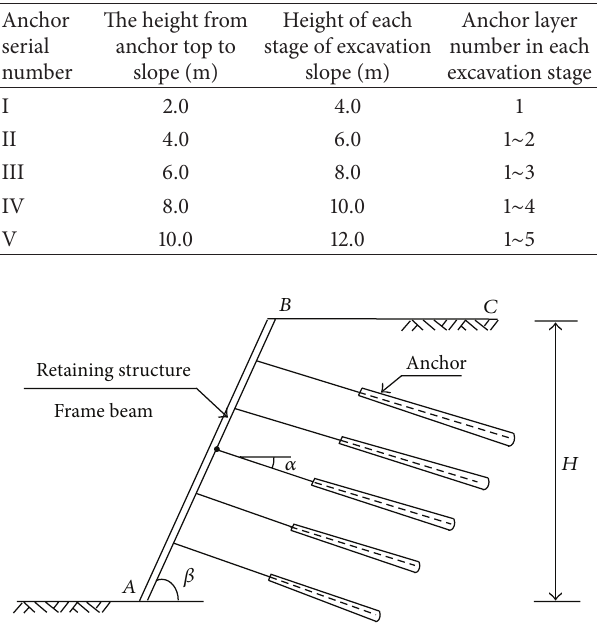
Table 2: Anchor arrangement for slope excavation stages.